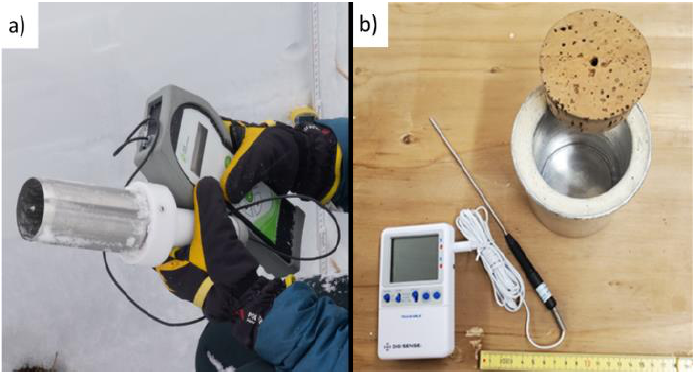
Figure 3. Image of ( a ) the A2 Photonics WISe Sensor and ( b ) the field calorimeter and thermometer used for this study.